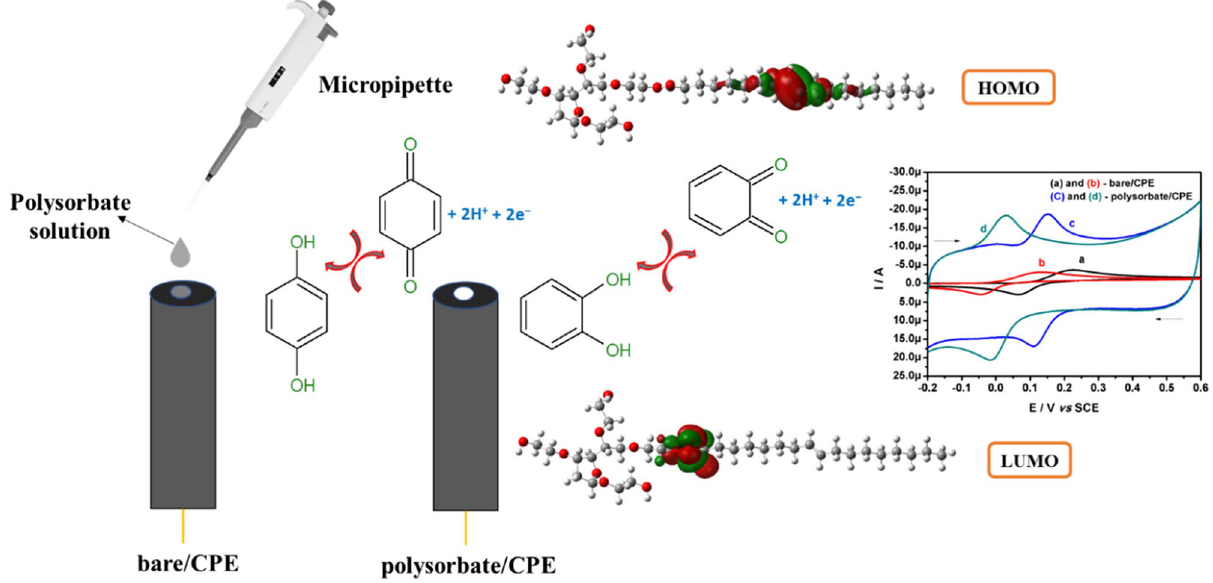
Figure 5. Fabrication of polysorbate/CPE and its electrocatalytic interaction with CC and